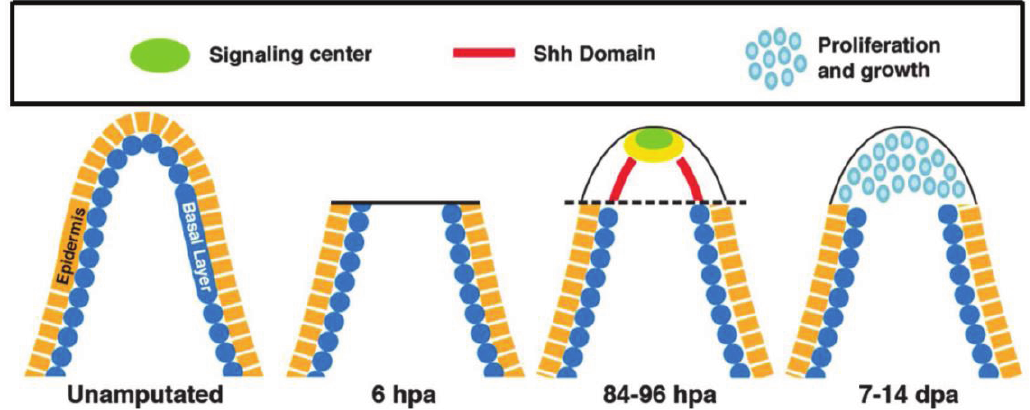
Figure 4. Sequence of regenerative events and HH signaling. Longitudinal section of an unamputated and regenerating fin ray showing the basal layer (blue) and outer epidermis (yellow). Epidermal cells cover the wound and mesenchymal cells from the stump proliferate and migrate distally to form the blastema. HH signaling is induced in the lateral basal epidermal layer and a signaling center (green) in the apical region (yellow) that includes: FGF, WNT and BMP signaling leads to the induction of cellular proliferation (blue) and regeneration. Note the key is in the upper